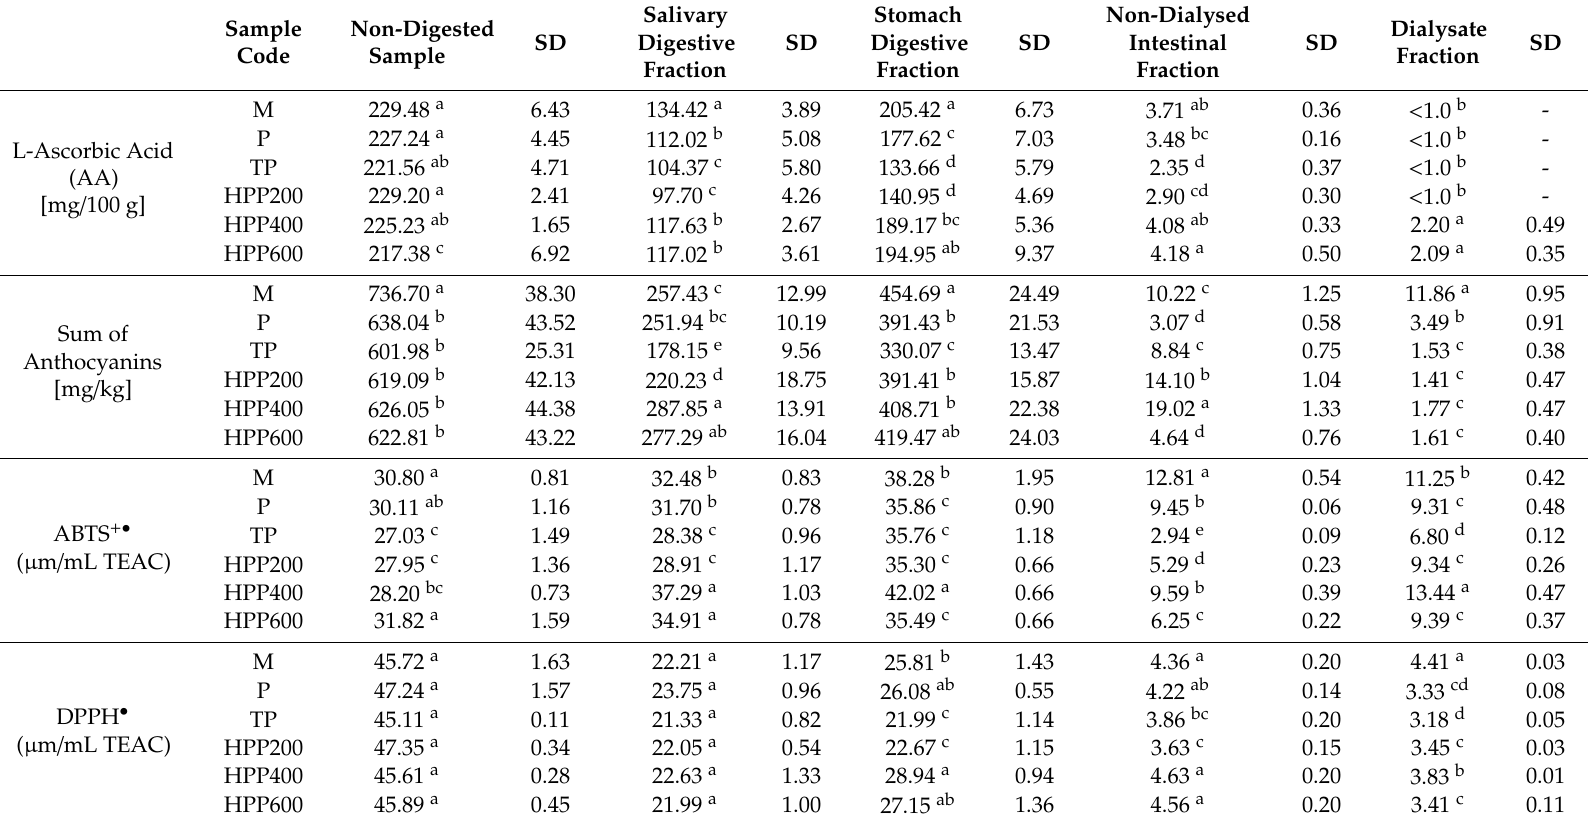
Table 1. Results of physicochemical analyses of blackcurrants at various stages of